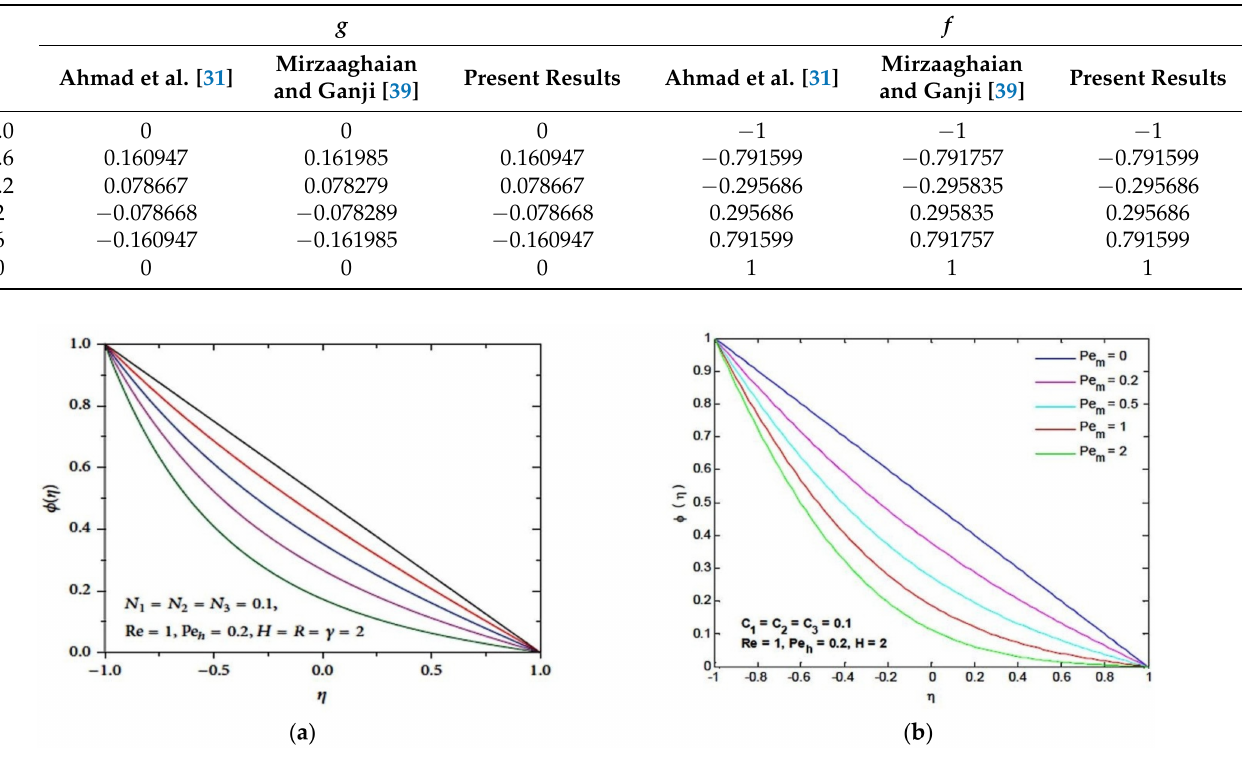
Figure 2. Comparison with concentration distribution φ ( η ) for several values of Pe m . ( a ) Singh and Kumar [40]; ( b ) Present